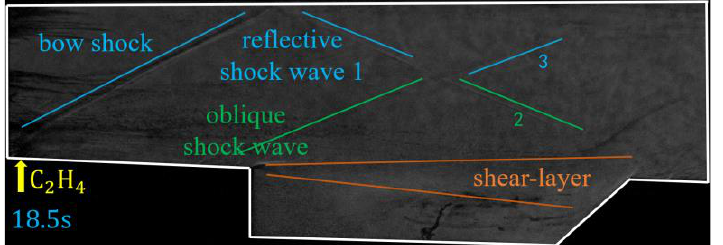
Figure 10. Shadowgraph at Case 5 (1.2D 0 II0.182), 1 — Reflected shock wave, 2 — Intersecting shock waves, 3 — Intersecting shock waves.